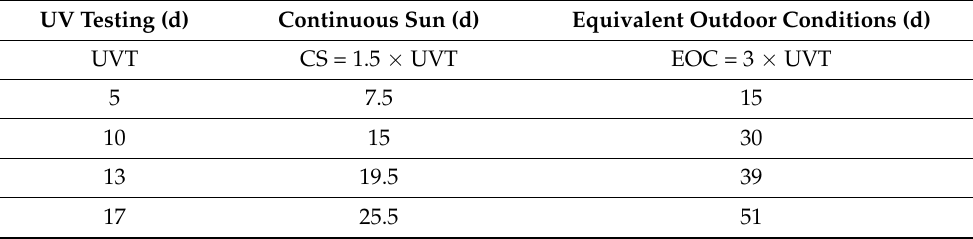
Table 5. Number of days (d) the OMO samples were irradiated with the indoor UVA radiation in the UV testing (UVT), along with the corresponding continuous sun (CS) and equivalent outdoor conditions (EOCs), in days.